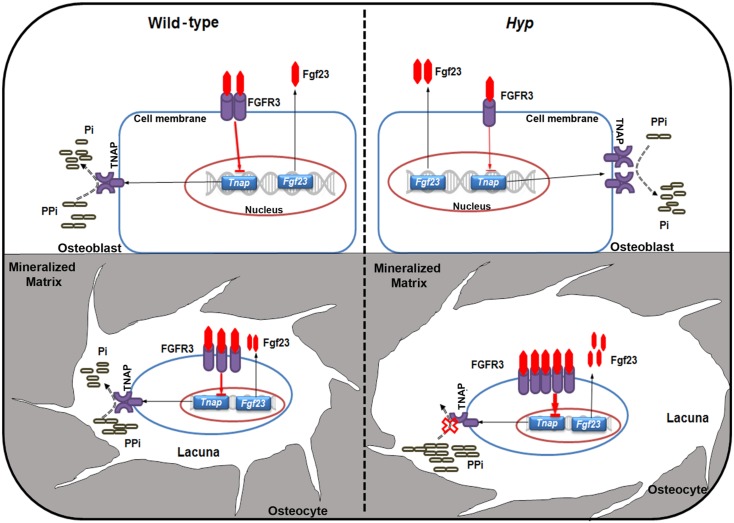
Proposed model of PPi accumulation through increased Fgf23-FGFR3 signaling in Hyp osteocytes.Fgf23 secreted into the extracellular fluid binds to FGFR3 and acts as a transcriptional suppressor of Tnap. TNAP is a central molecule in the mineralization process and favors mineralization through hydrolyzing PPi, thus providing Pi for mineralization. Fgf23 secretion is up-regulated in osteoblasts and especially osteocytes in Hyp bones, relative to WT osteoblasts and osteocytes. FGFR3 expression is reduced in Hyp compared with WT osteoblasts. However, differentiation of osteoblasts into osteocytes is associated with a distinct up-regulation of FGFR3 expression especially in Hyp bones. Together with the increased secretion of Fgf23, the upregulation in FGFR3 leads to autocrine/paracrine suppression of TNAP activity in Hyp osteocytes but not osteoblasts, causing accumulation of PPi and inhibition of bone mineralization in osteocyte lacunae.